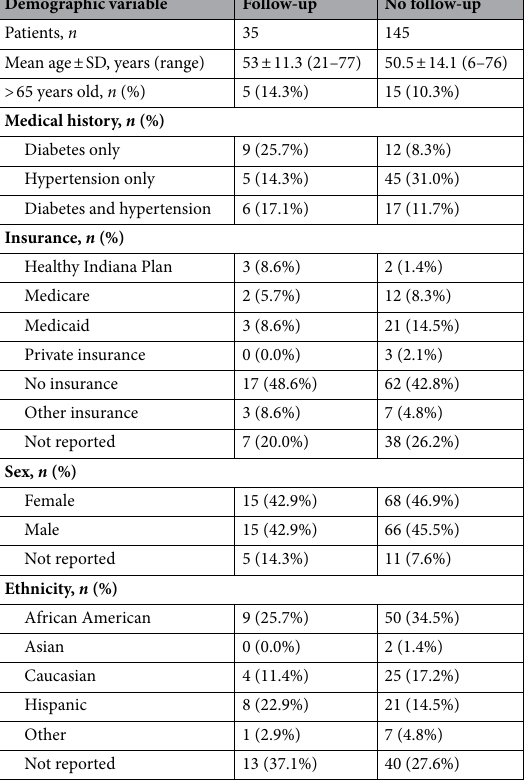
Table 1. Follow-up and no follow-up patient